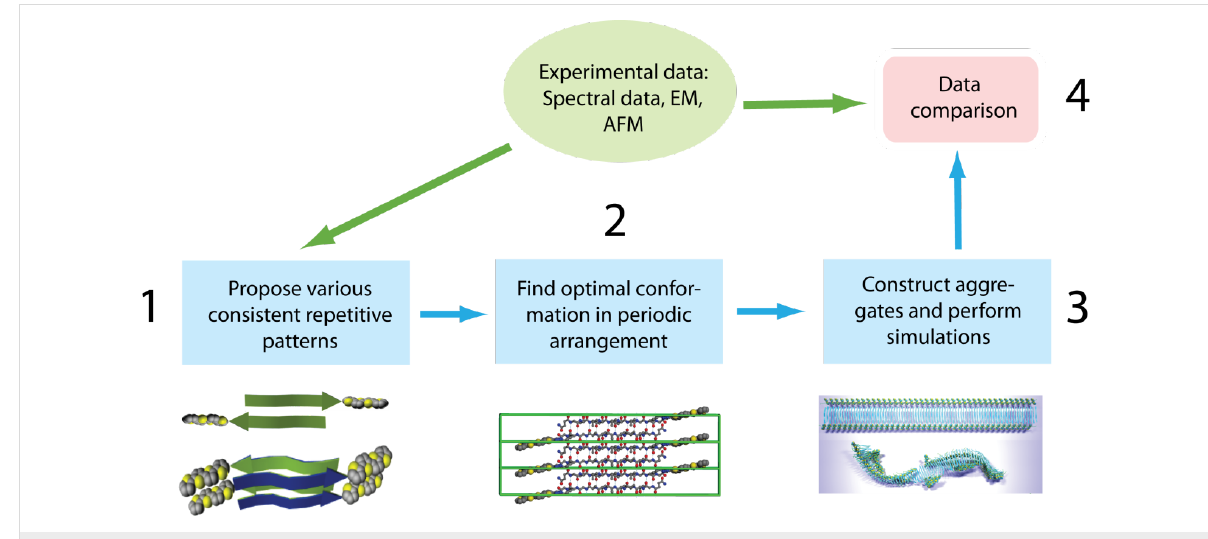
Figure 11: Theoretical analysis workflow (see